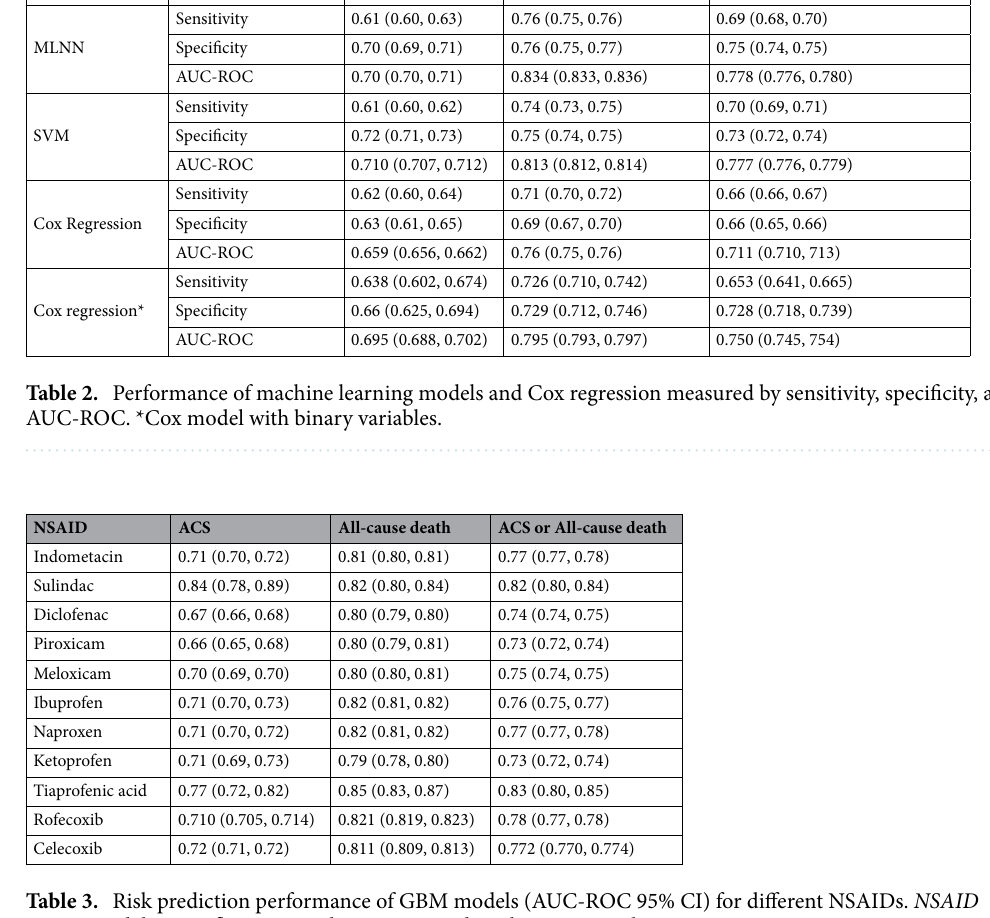
Table 3. Risk prediction performance of GBM models (AUC-ROC 95% CI) for different NSAIDs. NSAID non-steroidal anti-inflammatory drug, GBM gradient boosting